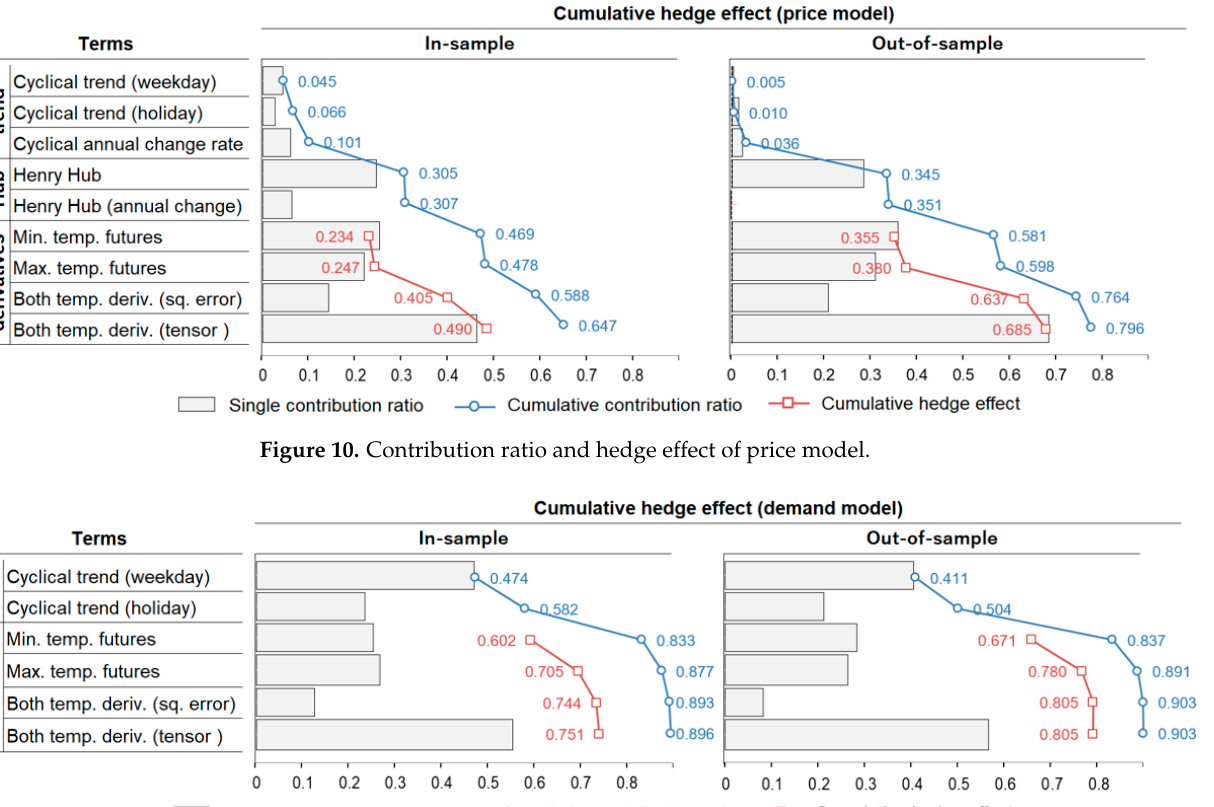
Figure 9. Contribution ratio and hedge effect of product model.